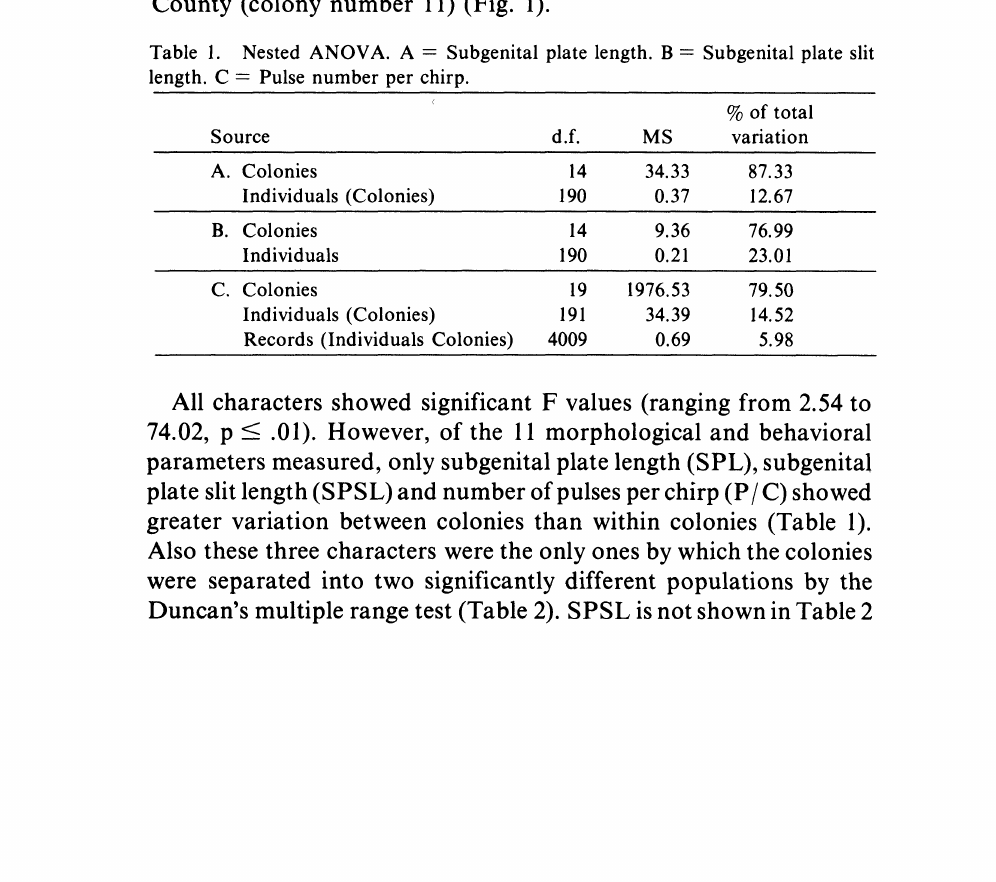
Table 1. Nested ANOVA. A Subgenital plate length. B Subgenital plate slit length. C Pulse number per